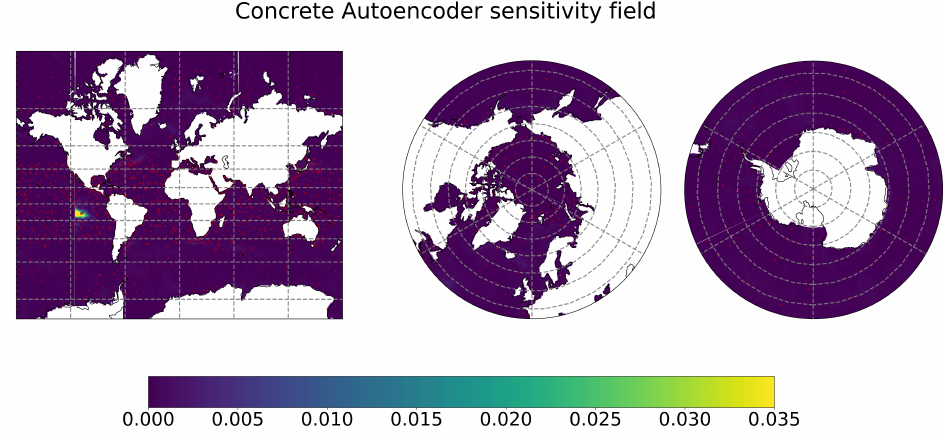
Figure 17. Sensitivity field of the Concrete Autoencoder for the temperature at 9 m from the training dataset.